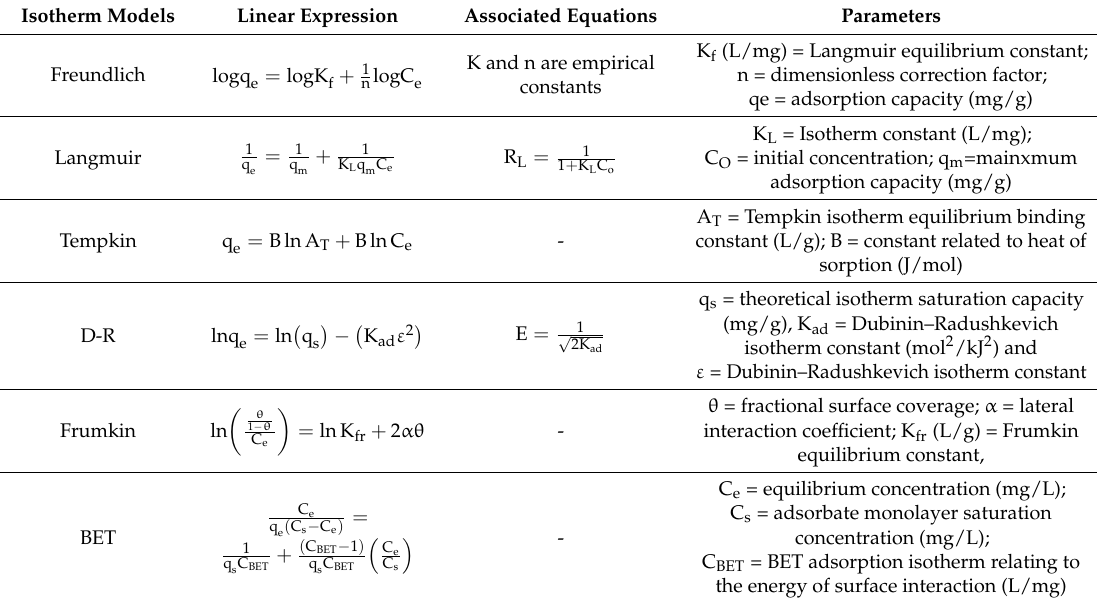
Table 3. Equilibrium study models [25–27,29–31].